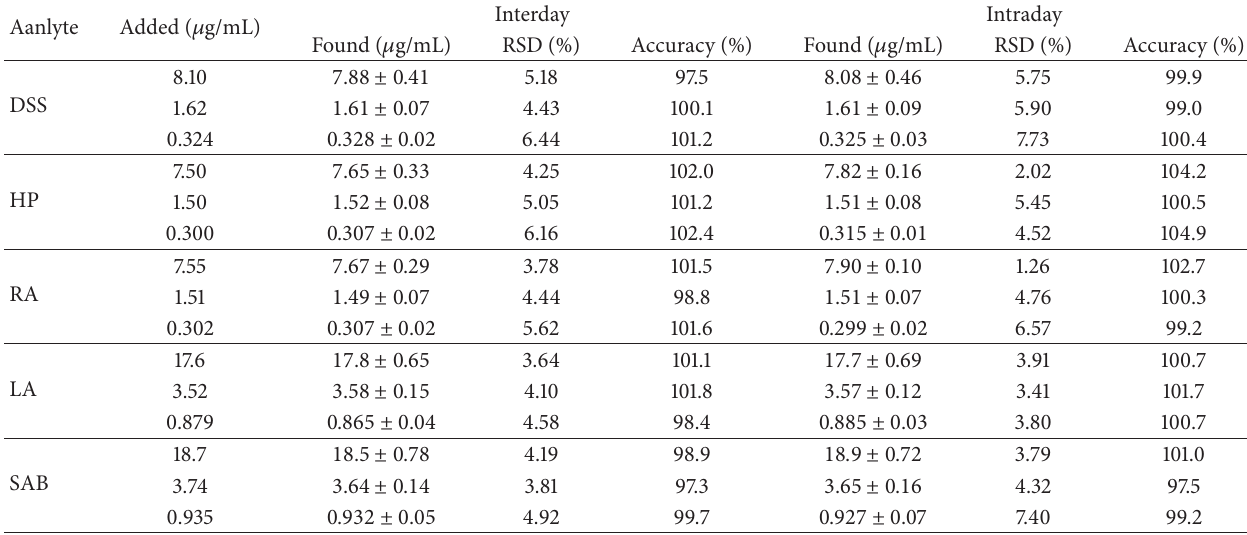
Table 2: Intra- and interday precision and accuracy for QC samples ( 𝑛 = 5 ). Aanlyte